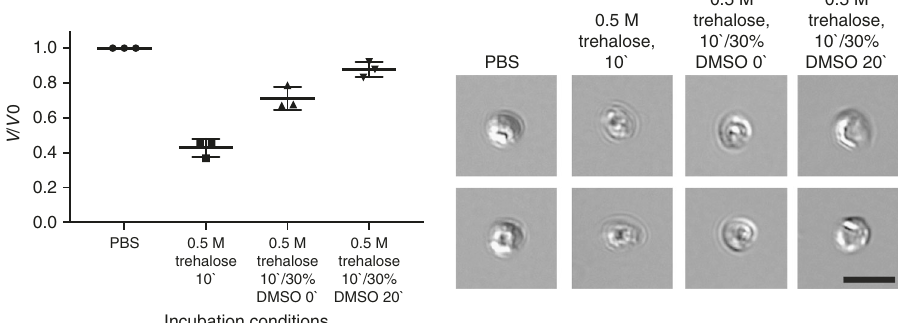
Fig. 4 Response of C. parvum to dehydration and CPA uptake prior to freezing. The shrink-swell response of bleached oocysts to a challenge with 1 M trehalose for 10 min, with or without subsequent addition of DMSO for 0 min or 20 min (at fi nal concentration of 0.5 M trehalose/30% DMSO) was measured by image analysis and compared to the PBS control. Loss of 57.2 ± 5.2% of oocyst volume related to dehydration in trehalose is partly restored by addition of DMSO. This is likely related to a decreased trehalose gradient after immediate addition of DMSO (0 min) or intra-oocyst uptake of DMSO during 20 min incubation. Values indicate means and error bars indicate standard deviation ( n = 3). DIC micrographs demonstrate volumetric changes of oocysts. Scale indicates 5 µ